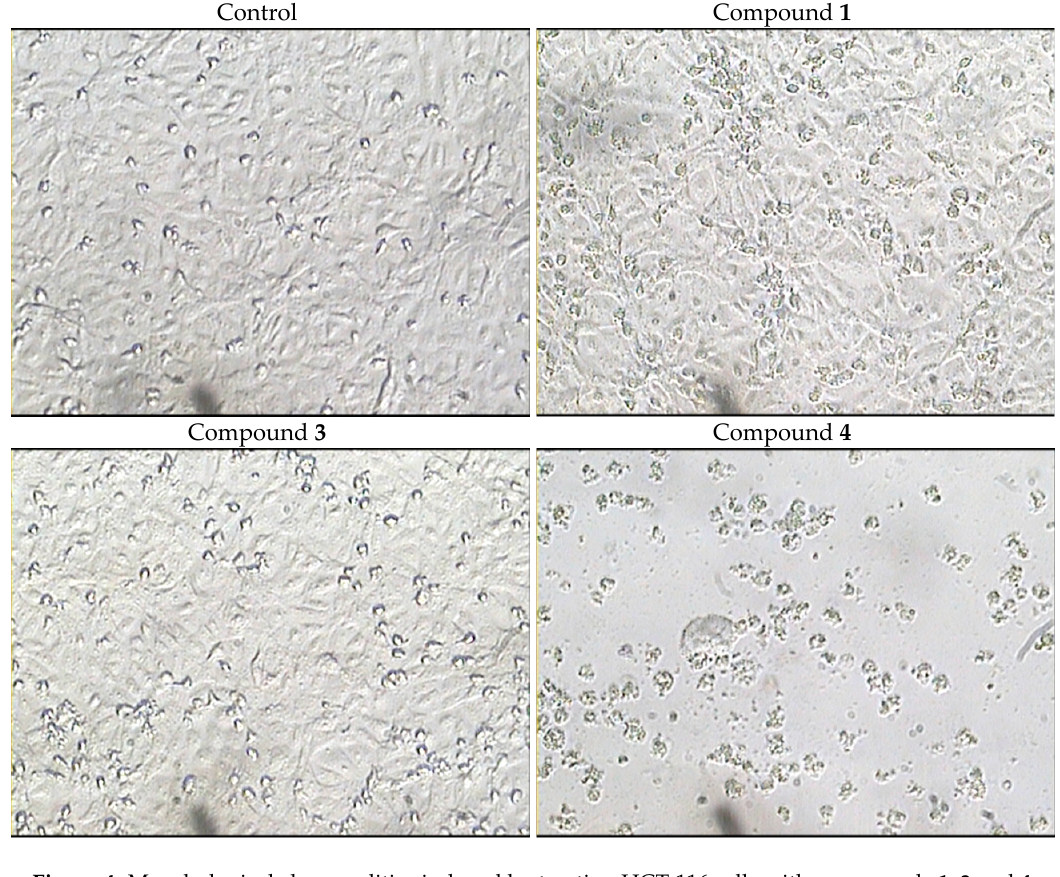
Figure 4. Morphological abnormalities induced by treating HCT-116 cells with compounds 1 , 3 and 4 (10 µM) for 72 h.